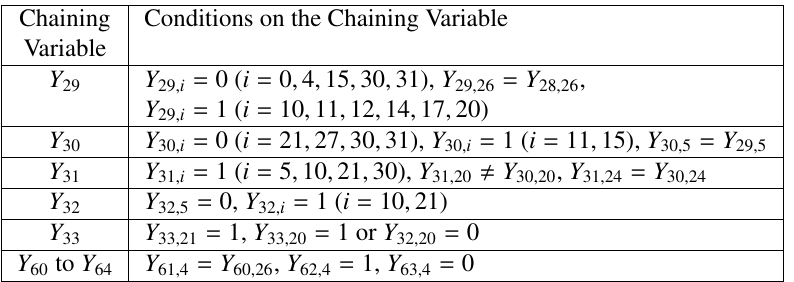
Table 9: The Conditions of Steps 29-33, 60-64 in Right Branch Chaining Conditions on the Chaining Variable